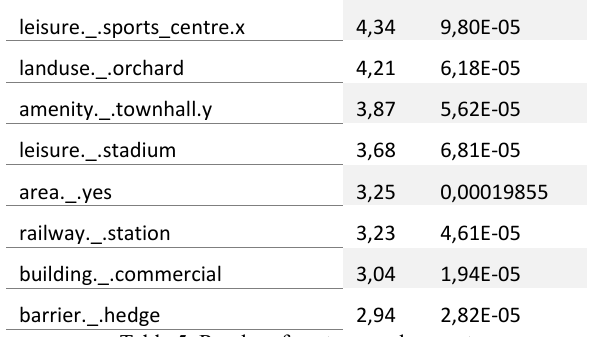
Table 5. Random forest